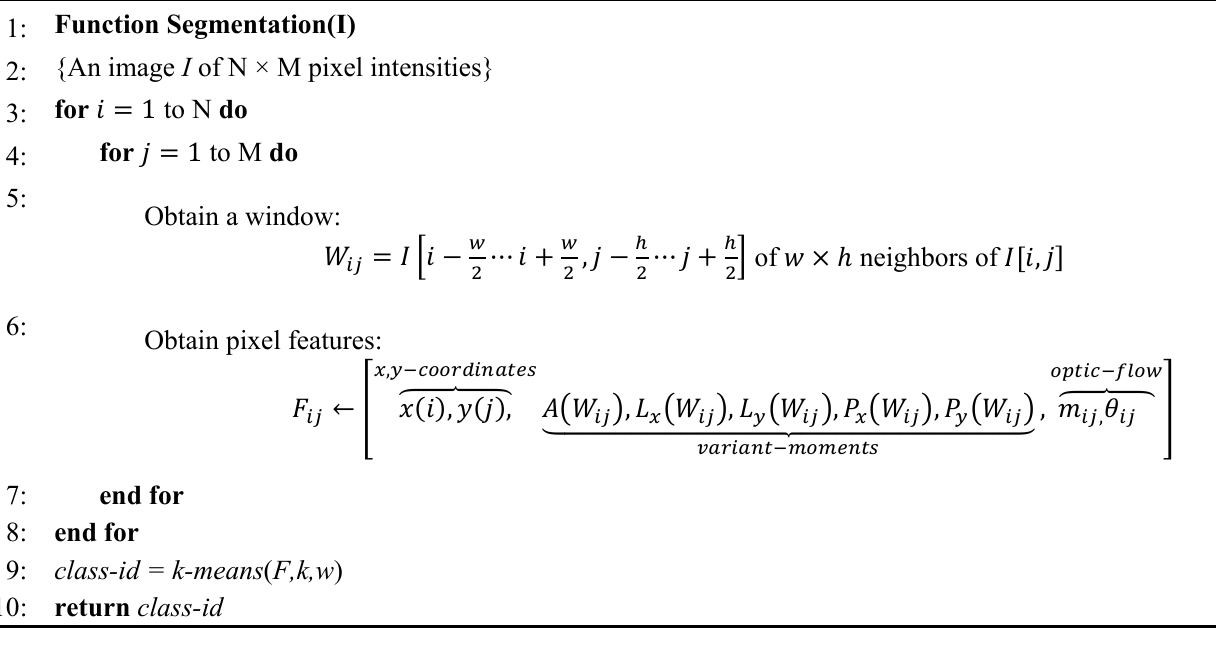
Algorithm 1. The proposed integrated segmentation algorithm incorporating the variant moments and the measures of optic flow, flow’s magnitude and phase of each pixel ( m